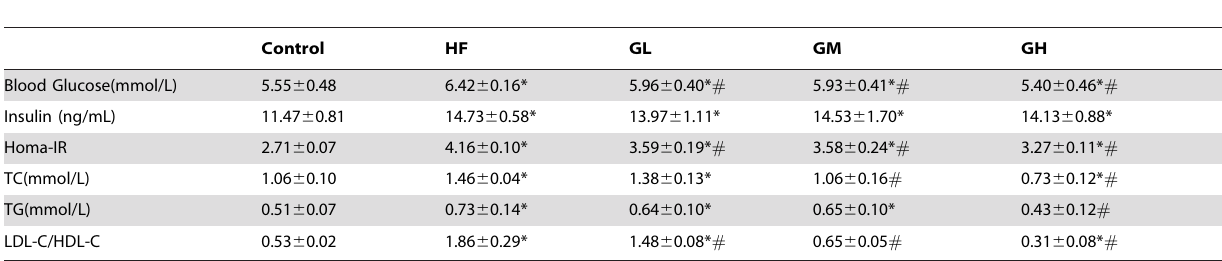
Table 1. GTPs downregulated the blood glucose and improved the lipid profile in HF fed